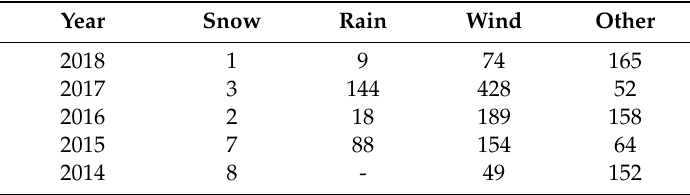
Table 2. Causes of construction disasters in Poland [5].